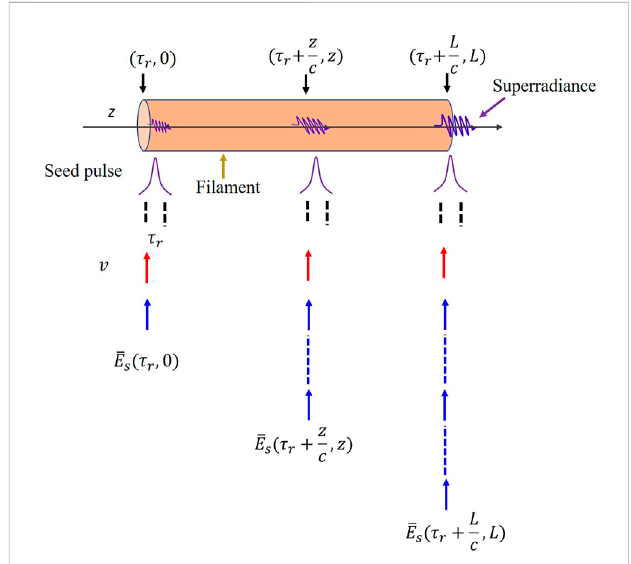
FIGURE 2 The amplitude of the radiation fi eld (cid:1) E s as a function of the plasma fi lament length L after the interaction between the seed pulse and the two-level system. The ground coordinate system is used for a concise